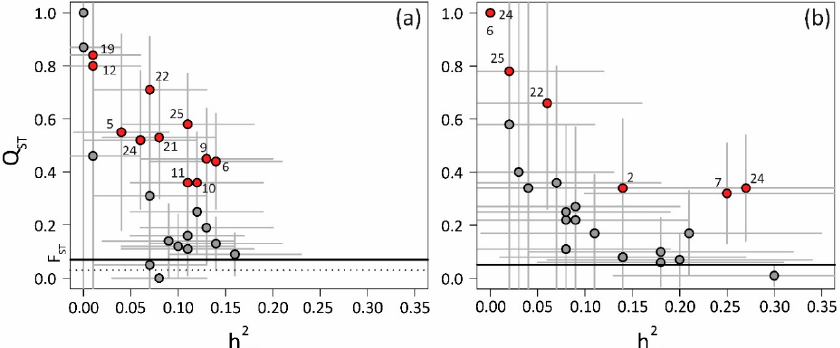
Figure 5. Quantitative inbreeding coe ffi cient ( Q ST ) and narrow-sense heritability ( h 2 ) estimates (with standard errors; grey lines) for traits reported in the present study for Eucalyptus pauciflora ( a ) and E. tenuiramis ( b ). The solid horizontal line indicates the maximum F ST (both Eucalyptus species) based on putatively neutral molecular markers ( E. pauciflora— microsatellite; E. tenuiramis— isozymes) and the dotted line indicates the mean F ST of any microsatellite locus ( E. pauciflora only). Symbols colored in red correspond to traits that exhibited significant signals of divergent selection ( Q ST > F ST ) after filtering traits for significant provenance variation (see Figure 3). Numbers next to symbols correspond to the trait numbers in Table 1.